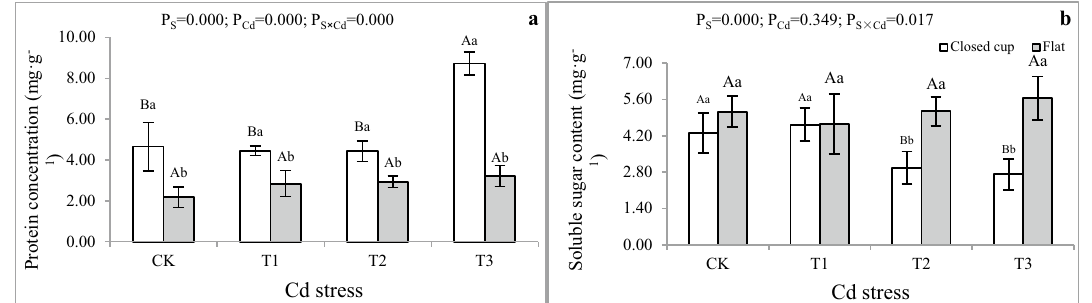
Figure 2. Effect of Cd stress on the content of soluble protein and sugar in the fruiting bodies of A. bisporus . ( a ) Soluble protein content. ( b ) Soluble sugar content. Different capital letters indicate significant differences among Cd stresses under the same sampling stage determined by LSD’s test with p < 0.05; different lower letters indicate significant differences within the sampling stage under the same Cd stress concentration determined by LSD’s test with p < 0.05. P S : effect of sampling time; P Cd : effect of Cd concentration; P S×Cd : Interaction between sampling time and Cd concentration. Error bar: